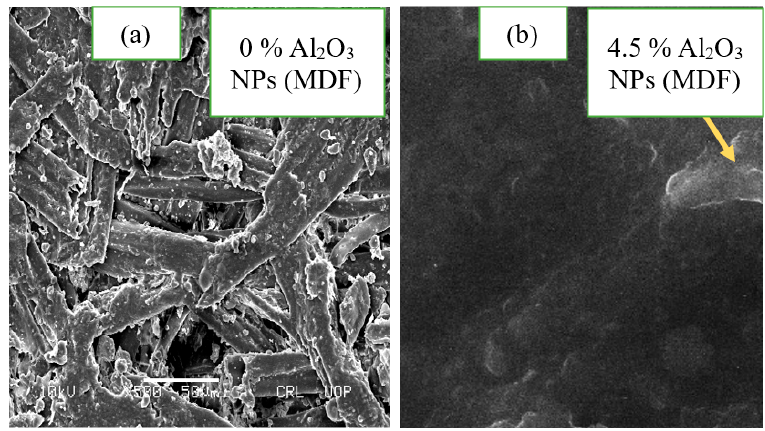
Figure 11. Scanning electron microscopic images of ( a ) medium density fiberboard without urea- formaldehyde and ( b ) with urea-formaldehyde.